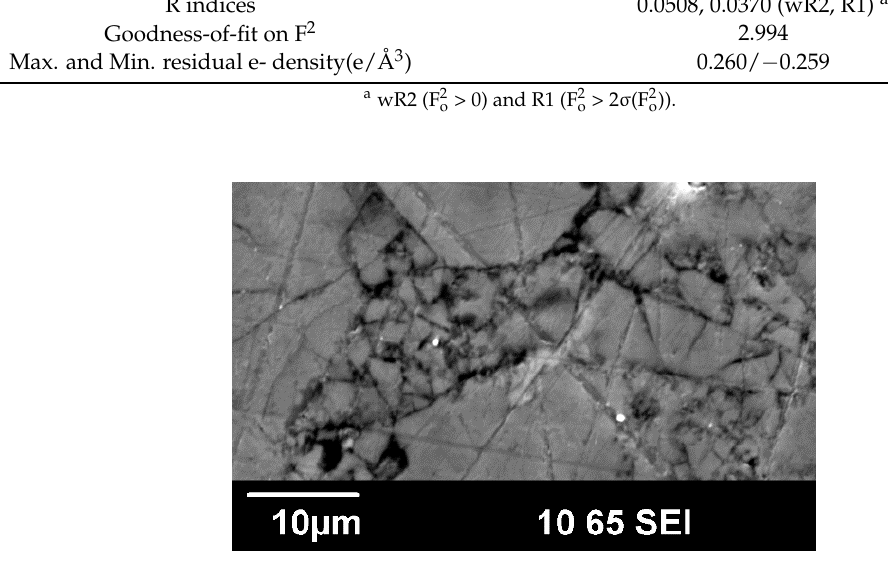
Figure 3. SEM image after the surface of the K 2.9(4) Ba 13.1(2) Ga 23.2(3) Sn 112.7(5) specimen was cracked and